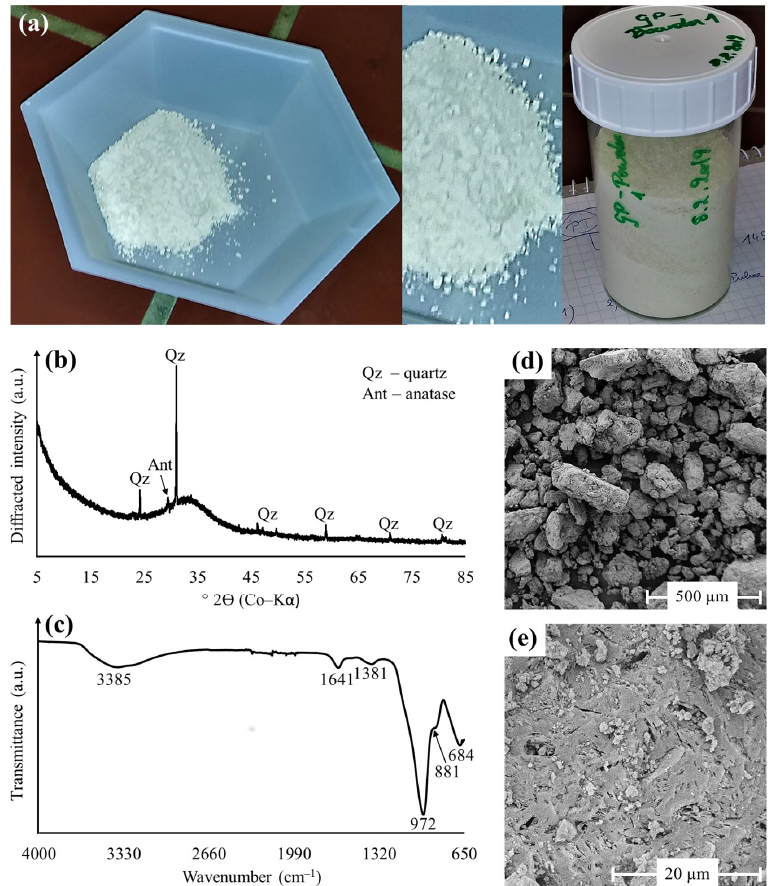
Figure 1. Optical appearance, mineralogical composition and microstructural features of granulated pristine GP used for the Cu 2+ immobilization studies. ( a ) Photograph; ( b ) XRD pattern; ( c ) FTIR spectrum; ( d , e ) SE images of GP.